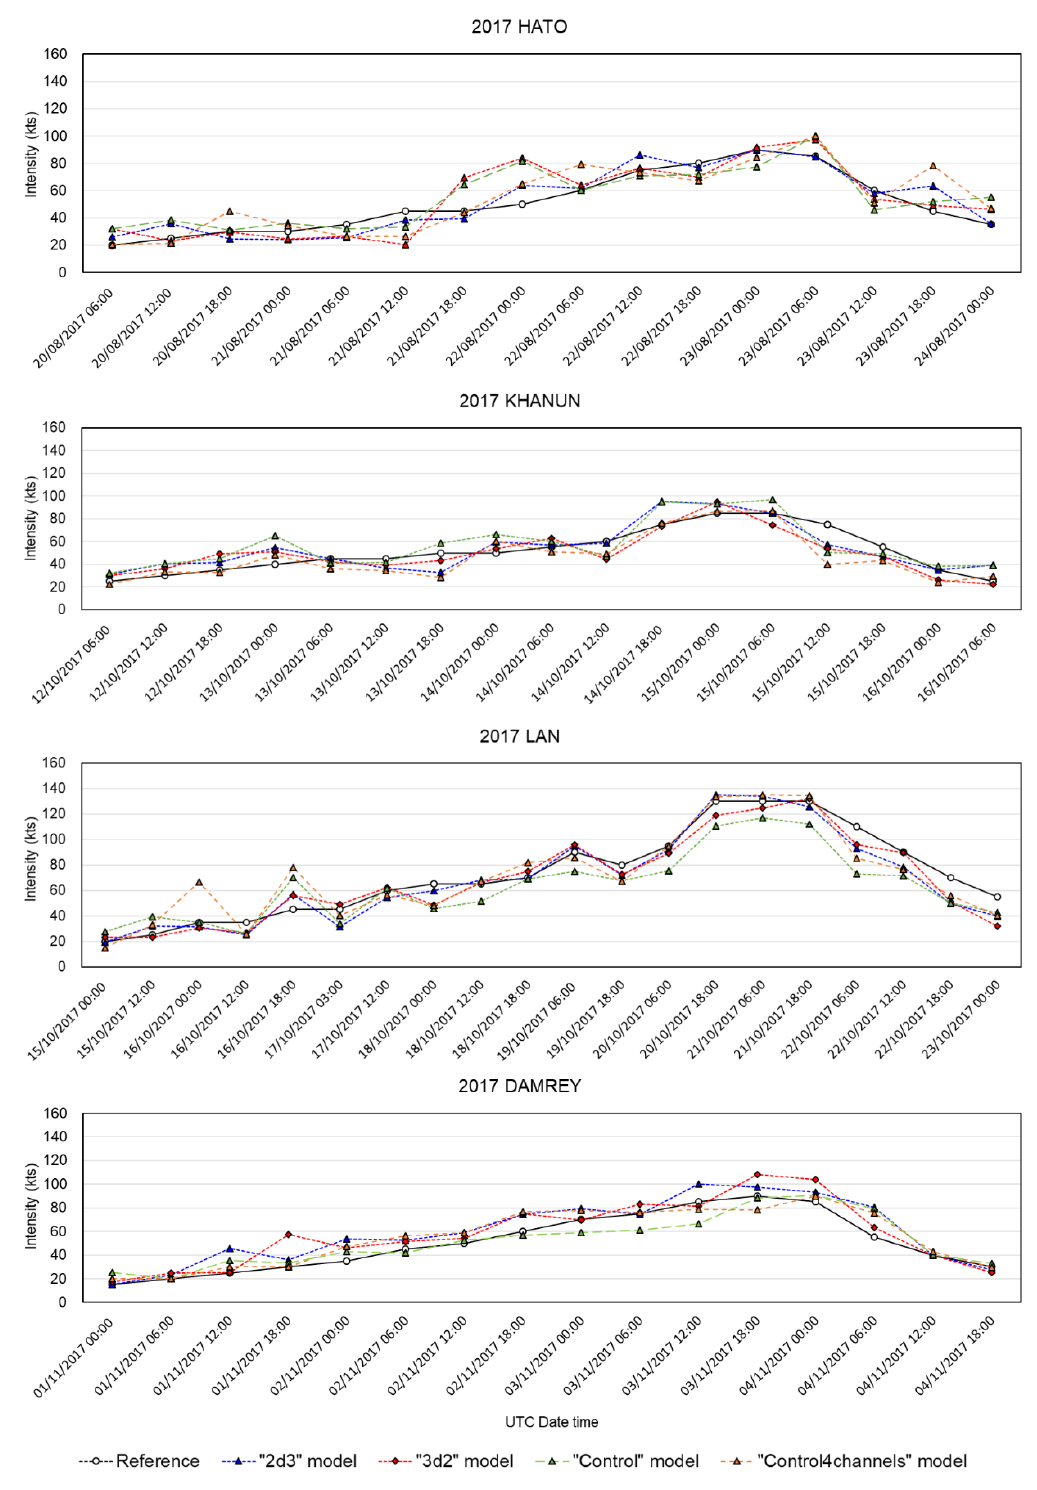
Figure 9. Time-series comparison of the additional hindcast validation results of four models (‘2d3’ and ‘3d2’ models which are proposed by this study and ‘Control’ and ‘Control4channels’ model, respectively) with JTWC best track data of typhoon HATO, KHANUN, LAN and DAMREY in 2017.